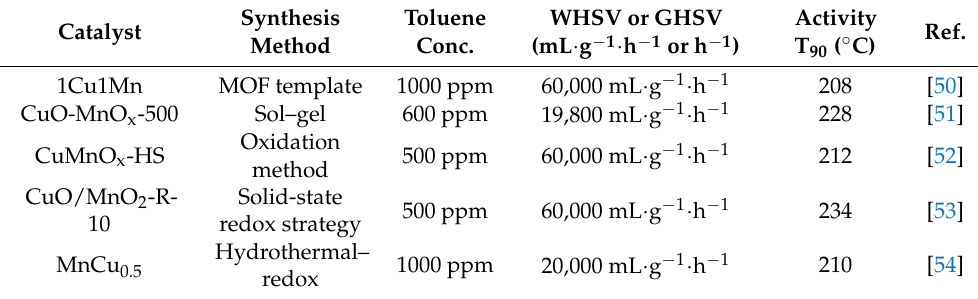
Table 2. Catalytic activity for toluene combustion over the binary composites reported in the recent